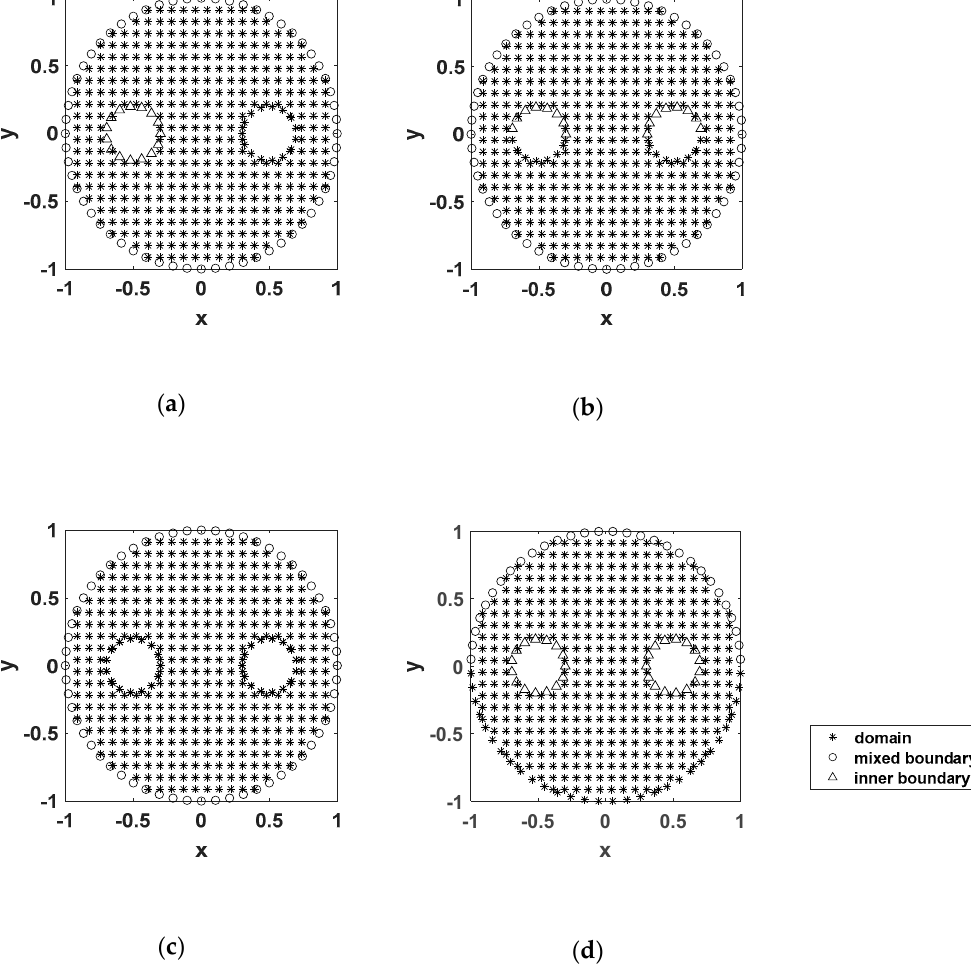
Figure 11. Discretization of type one multiply connected domains: ( a ) half unknown inner boundary; ( b ) two half unknown inner boundaries; ( c ) unknown inner boundaries; ( d ) half unknown outer boundary.